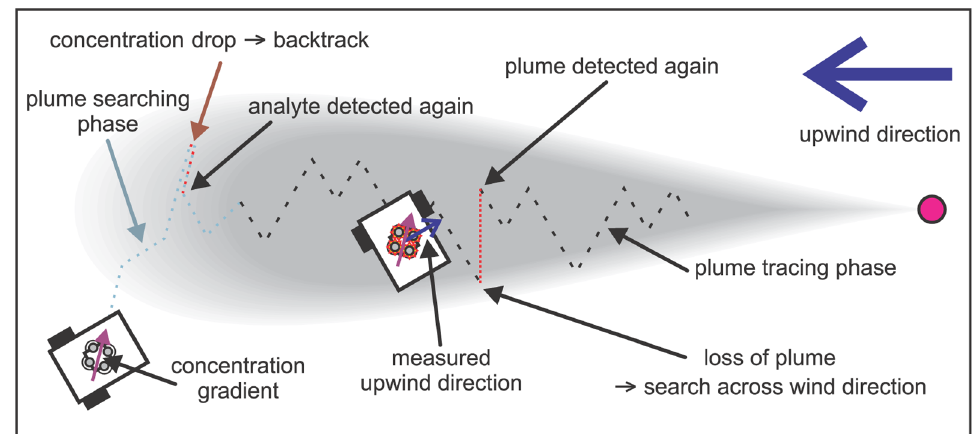
Figure 15 . Multiphase tracing algorithm (Ishida et al.